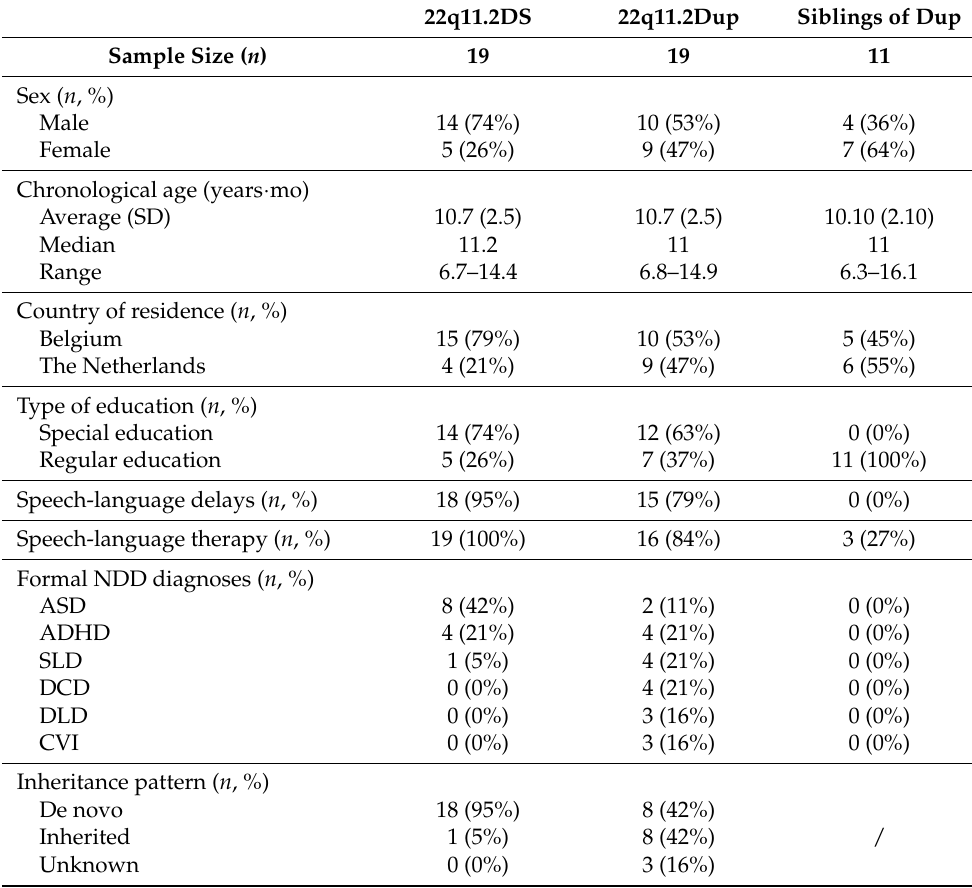
Table 1. Demographic and clinical characteristics across